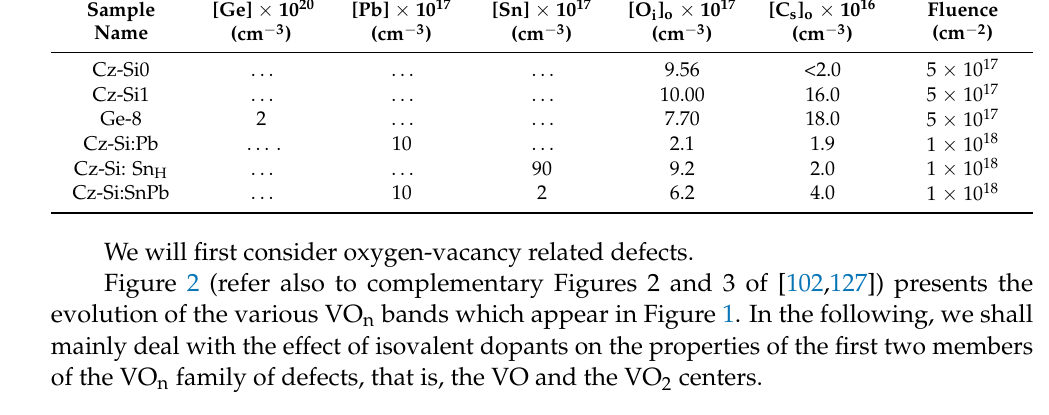
Figure 1. IR spectra of the Ge-8 sample ( a ), after irradiation at a fluence of 5 × 10 17 cm − 2 , and the Cz- Si:Pb ( b ), Cz-Si:Sn H ( c ), and Cz–Si:SnPb ( d ) samples, after irradiation at a fluence of 1 × 10 18 cm − 2 , at characteristic temperatures of the isochronal anneal sequence. Reproduced with permission from [102,127]. American Institute of Physics. Table 1. The O i , C s , Ge, Sn and Pb concentrations of the used samples for Figure 1 [102,127]. Sample